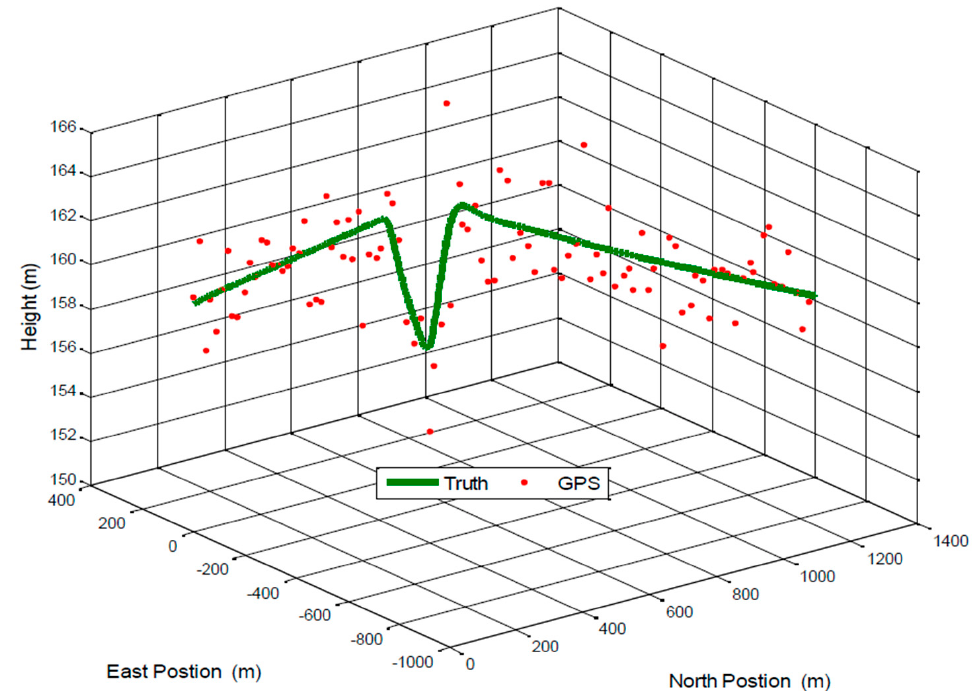
Figure 4. 3D position trajectory of a small UAV.